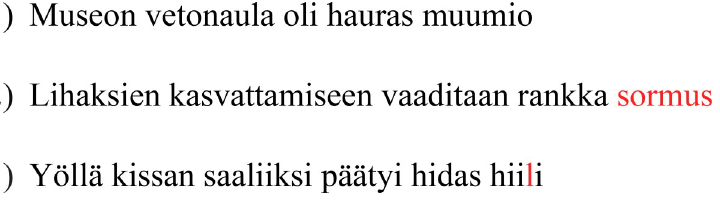
Fig 1. Example stimuli. The part of the sentence that deviates from the context is highlighted in red. Sentence translations: 1) plausible–‘Main attraction of the museum was the fragile mummy’; 2) unrelated anomalous–‘For building up muscle mass one needs an intense ring’; 3) anomalous word neighbour–‘During the night the cat caught a slow coal’ (‘hiili’, coal, being a neighbour of ‘hiiri’, a mouse).